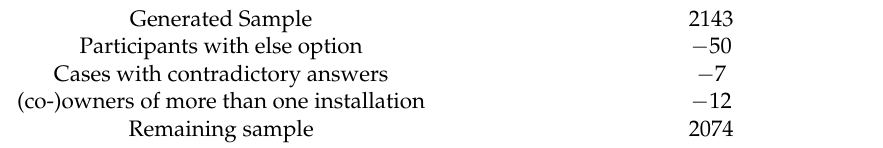
Table A3. Data cleaning process (source: authors’ own calculations).